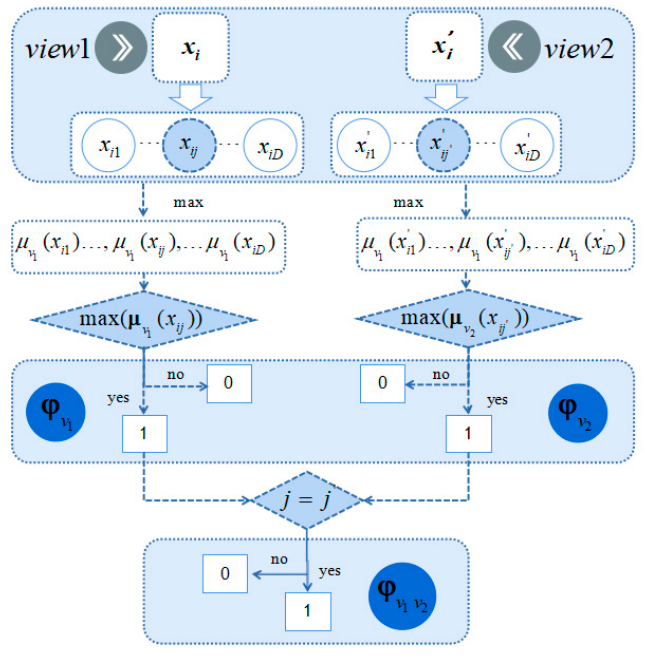
Figure 2. The decision coefficient matrix under the joint view.